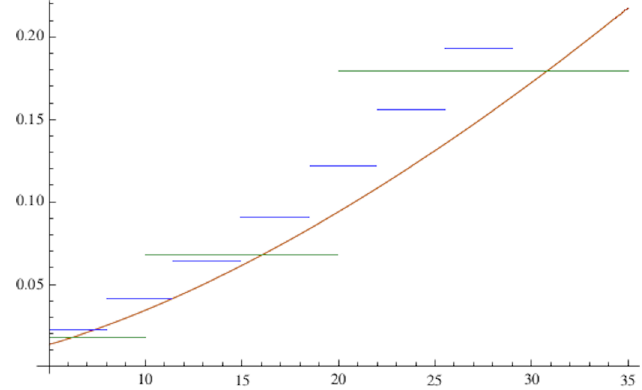
Figure 4 . Comparison of prediction (7.29) with lines depicting angular coefficient A 0 in bins of Q ⊥ and Y < 1 from ref. [18]. (long bins) and ref. [17] (short